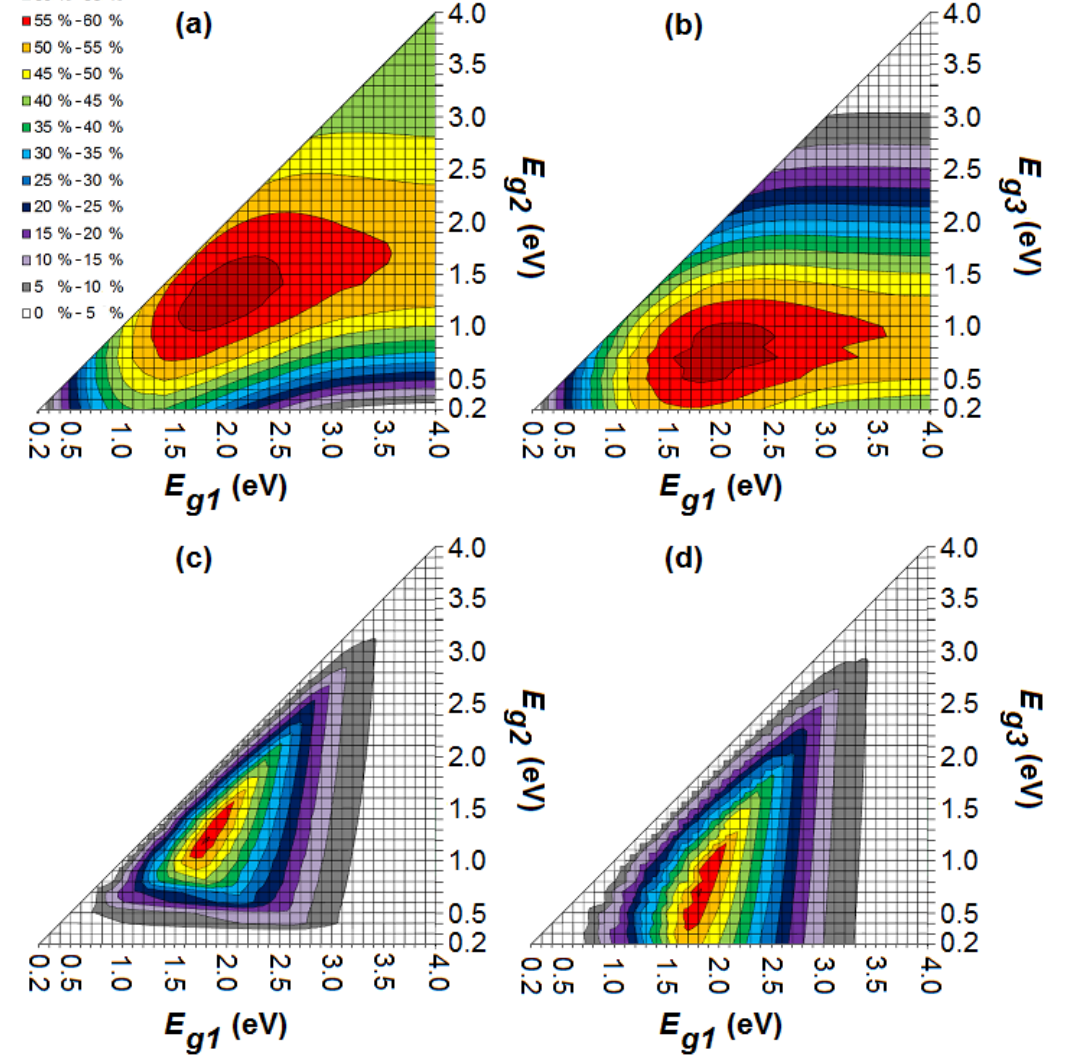
Figure 5. The maximum efficiency in the ideal scenario for a stacked ( a , b ) and monolithic ( c , d ) organic triple-junction solar cell with bandgaps E window and a LUMO difference of 0.2 eV between n - and p